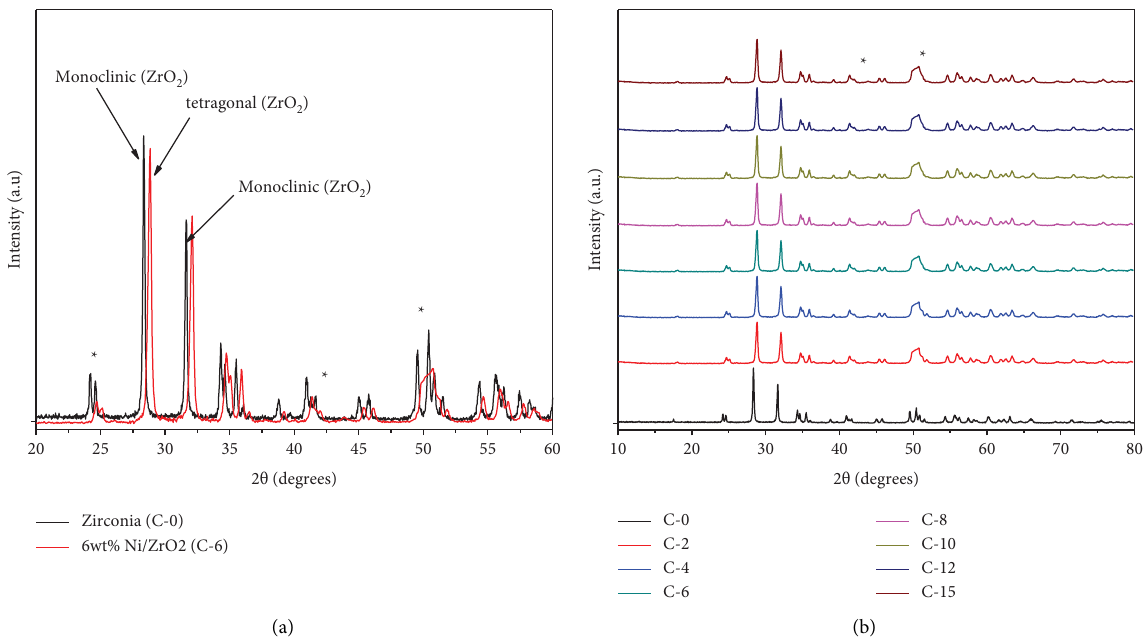
Figure 5: (a) XRD patterns of synthesized calcined Ni-loaded zirconia (6wt % Ni/ZrO presence of Ni). (b) XRD patterns of synthesized freshly calcined